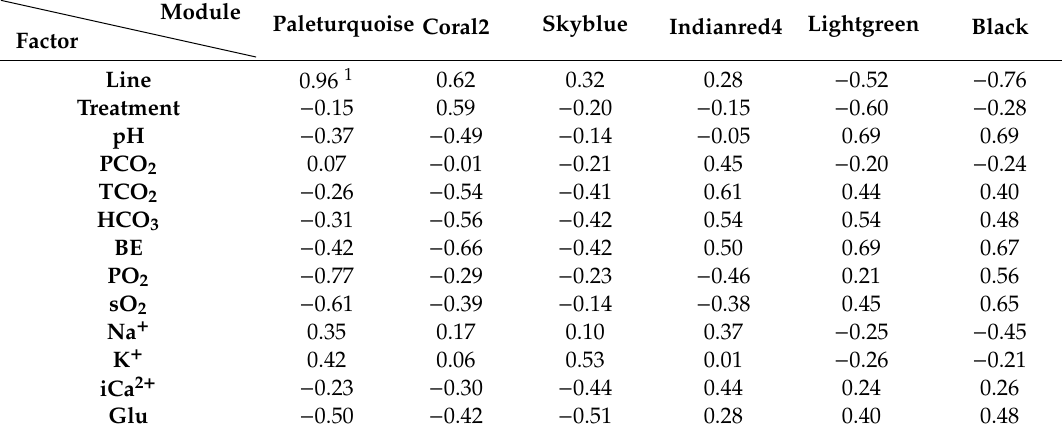
Table 5. Gene modules that were significantly associated with factors (line, treatment or blood phenotypes under the CH&NDV treatment.